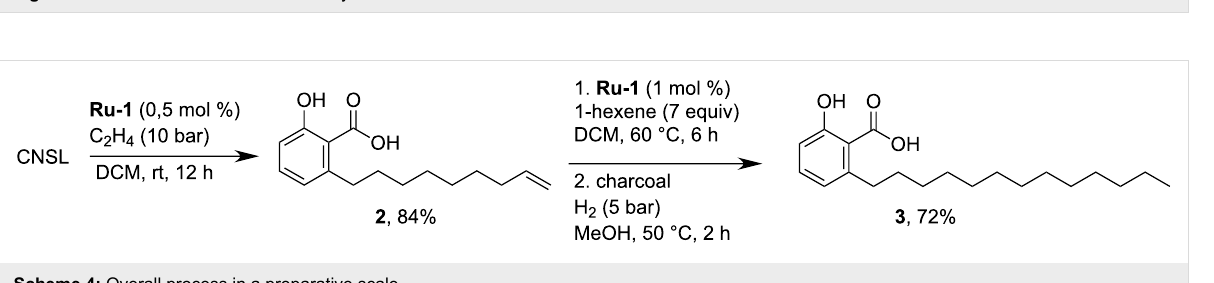
Figure 1: State-of-the-art metathesis catalysts.